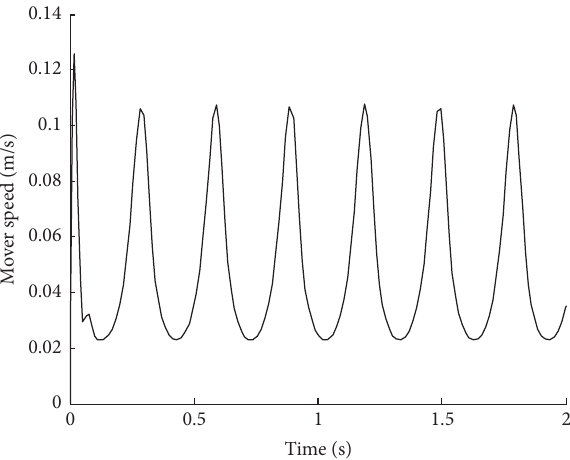
Figure 14: Simulation results of the mover velocity under an additional inertial load with the mass 𝑚 Δ = 19.2 kg for ] = 50